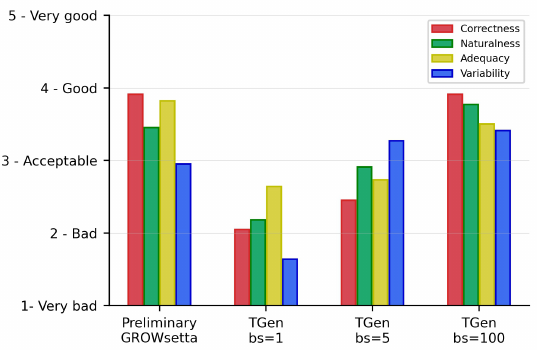
Figure A1. Average results of the human comparison of a preliminary version of GROWsetta and three versions of a statistical NLG built with TGen. The evaluation was conducted for the Spanish language.